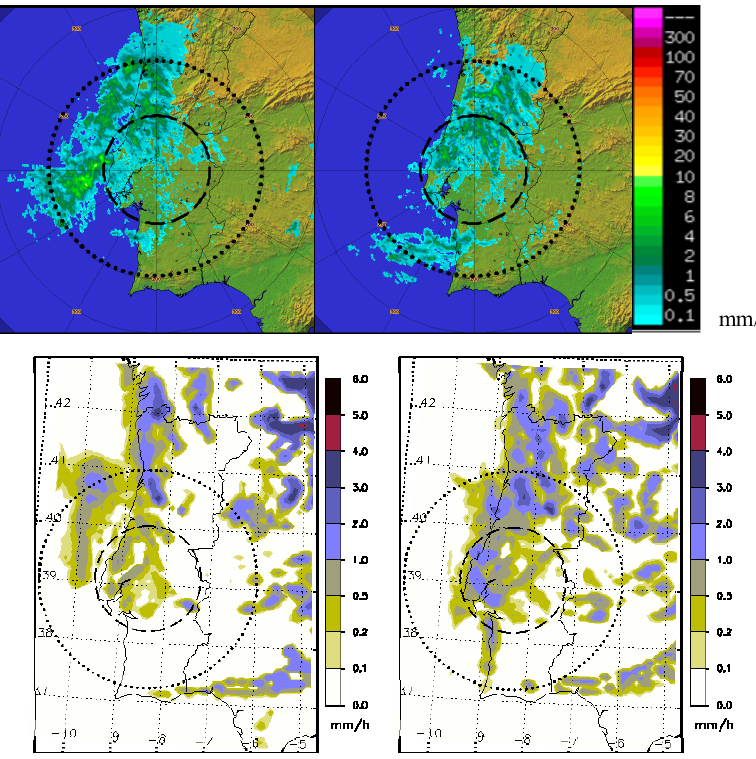
Fig. 2. Rainfall rate, in mmh − 1 , obtained from the C band Doppler radar measurements (upper panels) and corresponding modelling results Fig. 2 Rainfall rate, in mm h -1 , obtained from the C band Doppler radar measurements (upper (lower panels), on 4 June 2002 at 14:00UTC (left) and 16:00UTC (right). The dashed and dotted circles, delimit the 100 and 200km radar panels) and corresponding modelling results (lower panels), on 4 June 2002 at 1400 UTC range,